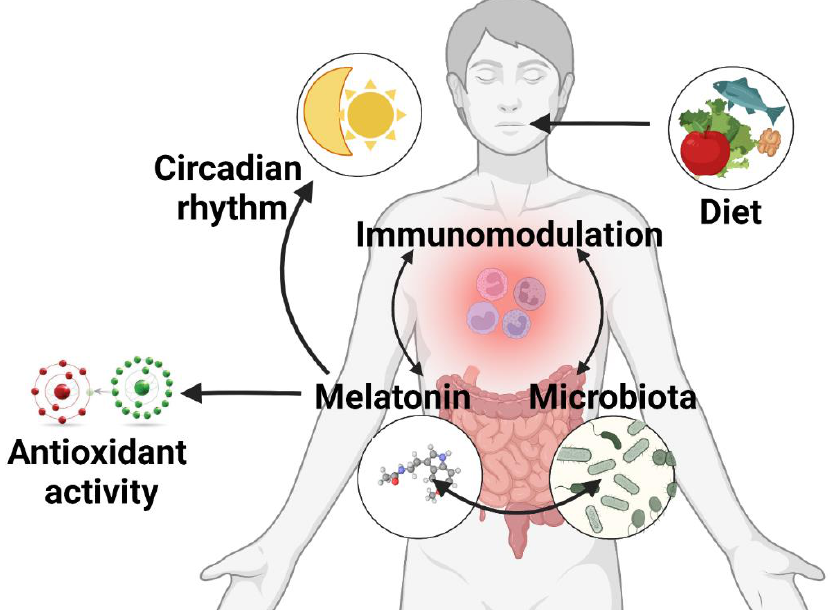
Figure 2. Diagram illustrating the interplay between melatonin and the gut microbiota. Melatonin indirectly modulates the enteric microenvironment through its systemic properties as an immunomodulator, antioxidant, and circadian rhythm regulator. Conversely, the re-established gut microbiota enhances this effect and contributes to the maintenance of body homeostasis. The intestinal bacteria impact melatonin production in the gut by influencing its synthesizing enzymes and precursors. Directly, melatonin could modulate the gut microbiota through molecular mimicry and antibacterial actions on pathogens, but most of the mechanisms warrant further research.